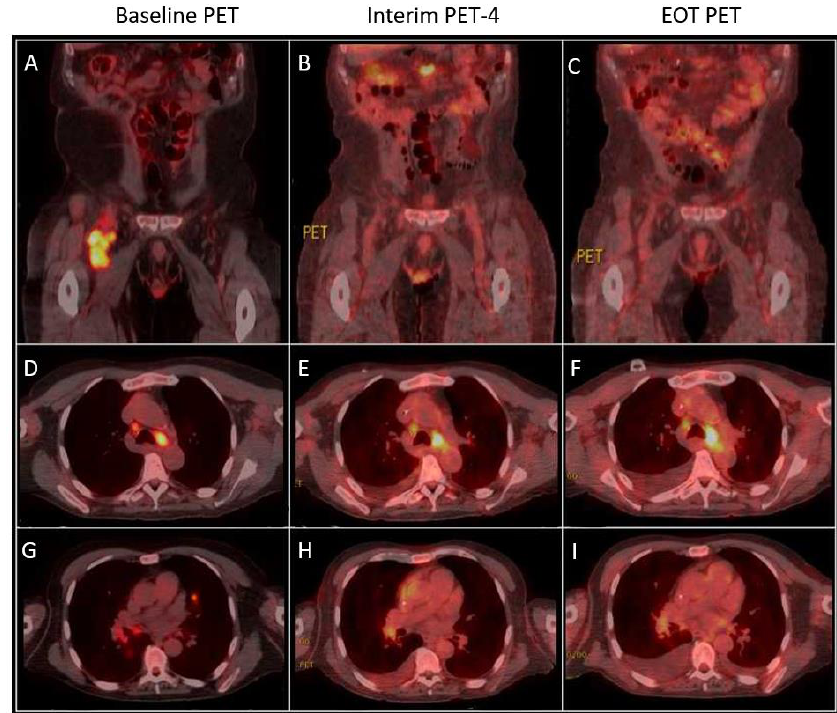
Figure 1. Comparison of baseline, interim, and end-of-treatment (EOT) PET-CT. ( A ) An abnormal 5.8 × 3.9 cm 2 soft tissue mass (SUV 11.9) adjacent to the proximal right femur demonstrates near complete resolution after cycle 4 (SUV 1.68) ( B ) and complete resolution after cycle 6 ( C ). ( D ) Enhancing mediastinal adenopathy (max SUV 13.4, Deauville Score 5) with significant improvement (SUV 9.3, Deauville Score 4) after cycle 4 ( E ) maintained after cycle 6 (Deauville Score 4) ( F ). ( G ) Abnormal FDG uptake of numerous subcentimeter bilateral pulmonary nodules (max SUV 8.4) with complete resolution after cycle 4 ( H ) and maintained after cycle 6 ( I ). An excisional biopsy of the soft tissue mass showed diffuse infiltration with atypical monomorphic lymphoid cells with large regions of necrosis (Figure 2). By immunohisto- chemistry the tumor cells expressed CD3, CD4, CD30 (30%), and BCL-2, and were nega- tive for CD5, CD8, CD10, CD20, CD21, TIA-1, perforin, T-cell receptor (TCR) gamma, and ALK-1. In situ hybridization for Epstein–Barr virus (EBV)-encoded RNA was negative and plasma EBV DNA was not detectable. The proliferation index estimated by Ki-67 staining was 70–80%. TCR gene rearrangement analysis showed a monoclonal band for both the TCR gamma and beta genes. A bone marrow biopsy showed normocellular bone marrow, with trilineage hematopoietic maturation, and no lymphoid aggregates or atyp- ical lymphoid cells, but with a mononoclonal TCR rearrangement identical to that found in the soft tissue mass, consistent with a low-level involvement by T-cell lymphoma. He was diagnosed with stage IV CD30-positive T-cell PTLD, peripheral T-cell lymphoma (PTCL), which was not otherwise specified (NOS).